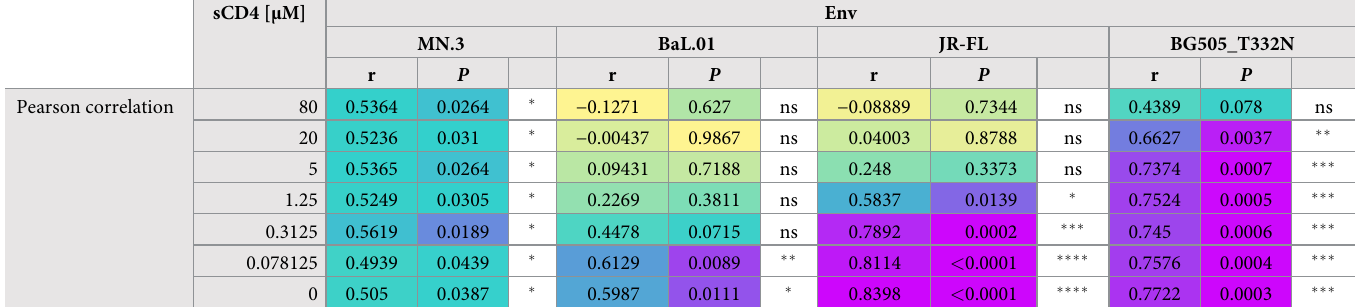
Correlation between MFI of antibody binding to the cell surface–expressed CD4-unbound as well as progressively more CD4-bound MN.3, BaL.01, JR-FL, and BG505_T332N Env and AUC for neutralization of the corresponding pseudovirus. CD4bs-directed inhibitors were excluded from the analysis, as their apparent affinity toward Env in the on-cell sCD4 triggering assay is influenced by direct competition for binding with sCD4. Pearson’s r coefficients and respective two-tailed P values are listed. High correlation/low P values are shaded in purple; low correlation/high P values are shaded in yellow. Abbreviations: AUC, area under the inhibition curve; BG505_T332N, BG505.W6M.ENV.C2_T332N; CD4bs, CD4 binding site; Env, envelope glycoprotein; MFI, mean of fluorescence intensity; ns, not significant; sCD4, soluble CD4.